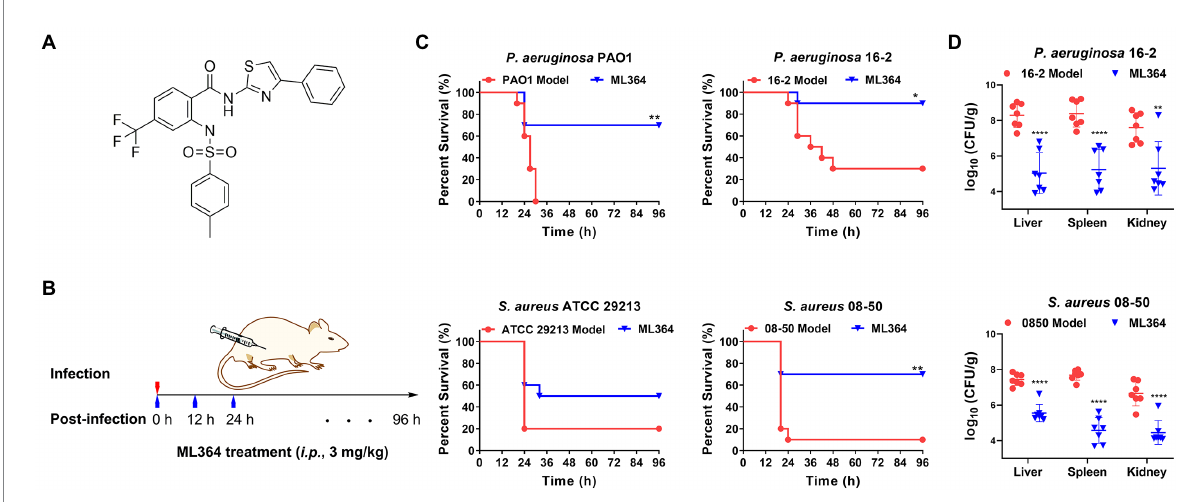
FIGURE 5 The in vivo studies of ML364. (A) The chemical structure of ML364. (B) The drug administration procedure in systemically infected mice. (C) Mice were intraperitoneally infected with Pseudomonas aeruginosa PAO1, CRPA 16-2, Staphylococcus aureus ATCC 29213, and MRSA 08-50. A dose of 3 mg/kg ML364 was intraperitoneally injected at 0, 12, and 24 h post-infection. Survival rates of mice were monitored until 4 days post-infection. (D) Bacterial loads in organs (liver, spleen, and kidney) influenced by ML364 therapy in the CRPA 16-2 and MRSA 08-50 infection model counted at 26 h post-infection ( n = 7 per group). * p < 0.05, ** p < 0.01, **** p < 0.0001 (Compared with the model